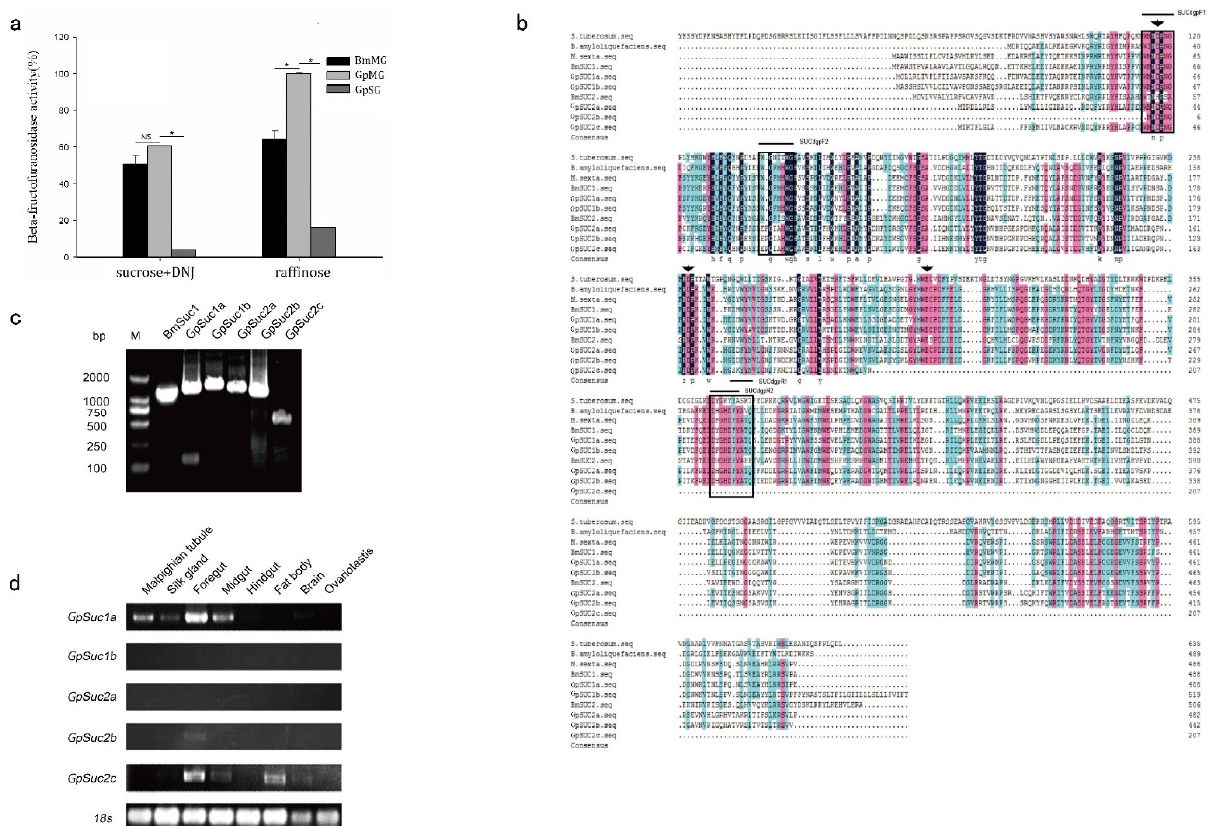
Figure 1. BmSuc1 homologous gene GpSuc1 was identified in G. pyloalis . ( a ) β -FFase activity in different tissues (BmMG, B. mori midgut). β -FFase activity in BmMG and GpMG were significantly